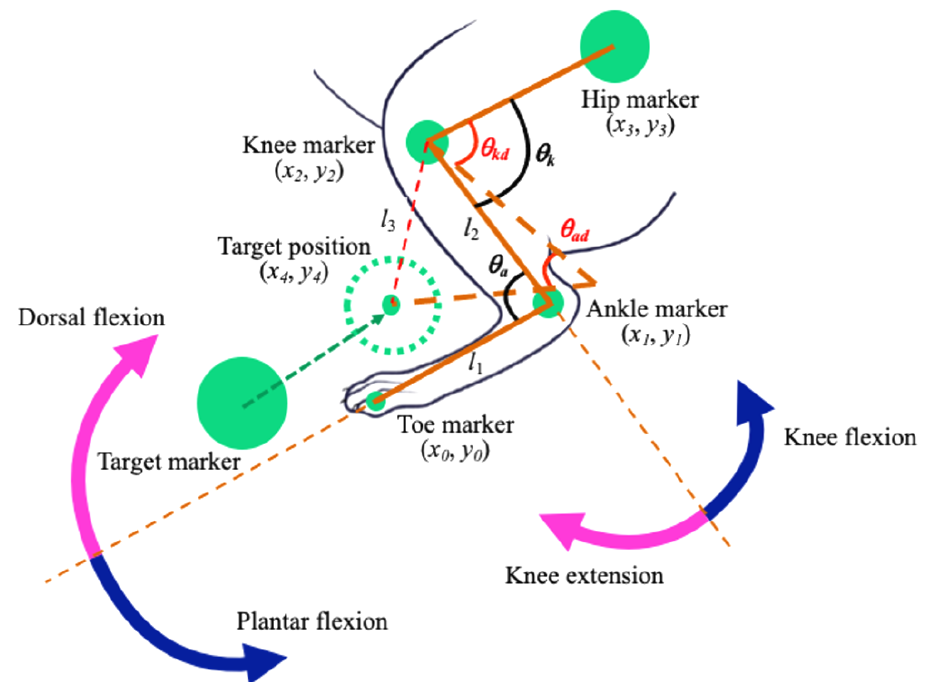
Figure 5. Experimental setup for visual feedback control of the rat knee and ankle joint